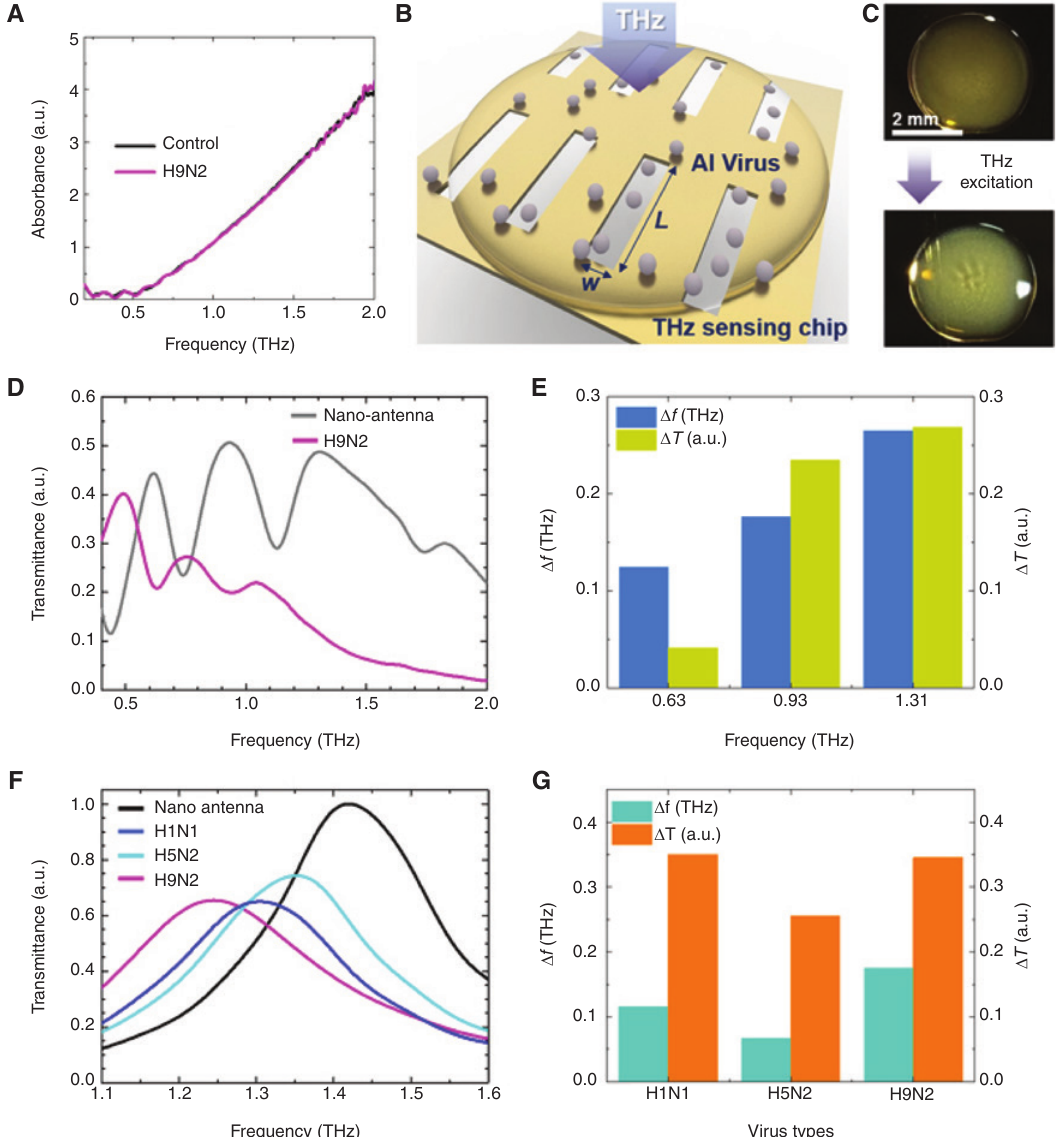
Figure 28: THz metamaterials for versatile detection of molecules. (A) Absorption spectra for pallet types of virus included a protein sample (H9N2) and a control without virus. (B) THz detection of virus samples in liquid state using a nano slot-antenna array-based sensing chip. (C) Optical images of dropped virus solutions onto the multires- onance nano-antenna array before (top) and after (down) THz excitation. (D) Transmittance spectra through multiresonance nano-antenna with and without H9N2 virus. (E) The difference in transmitted intensity ( Δ T ) and shifted resonance frequency from each fundamental reso- nance peak ( Δ f ) for H9N2 virus. This figure is reproduced from Ref.